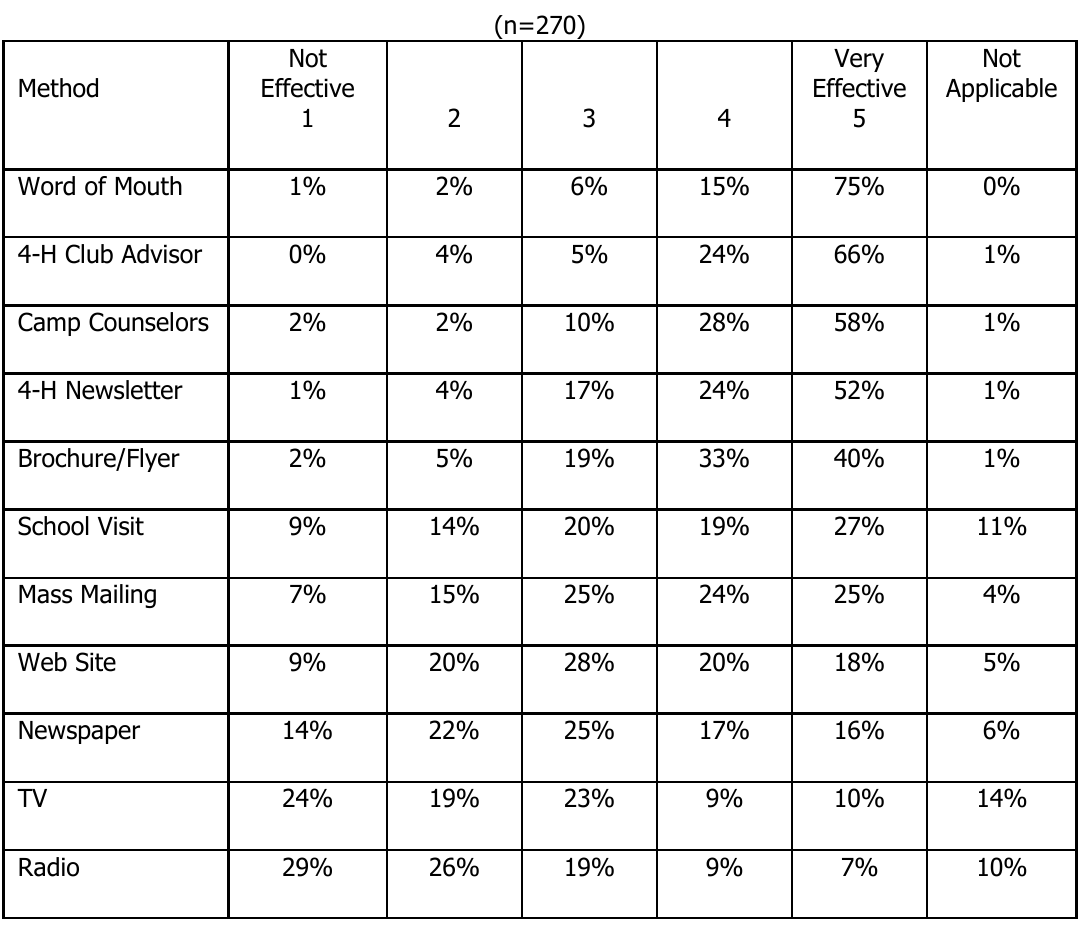
What is the Most Effective Way to Promote 4-H